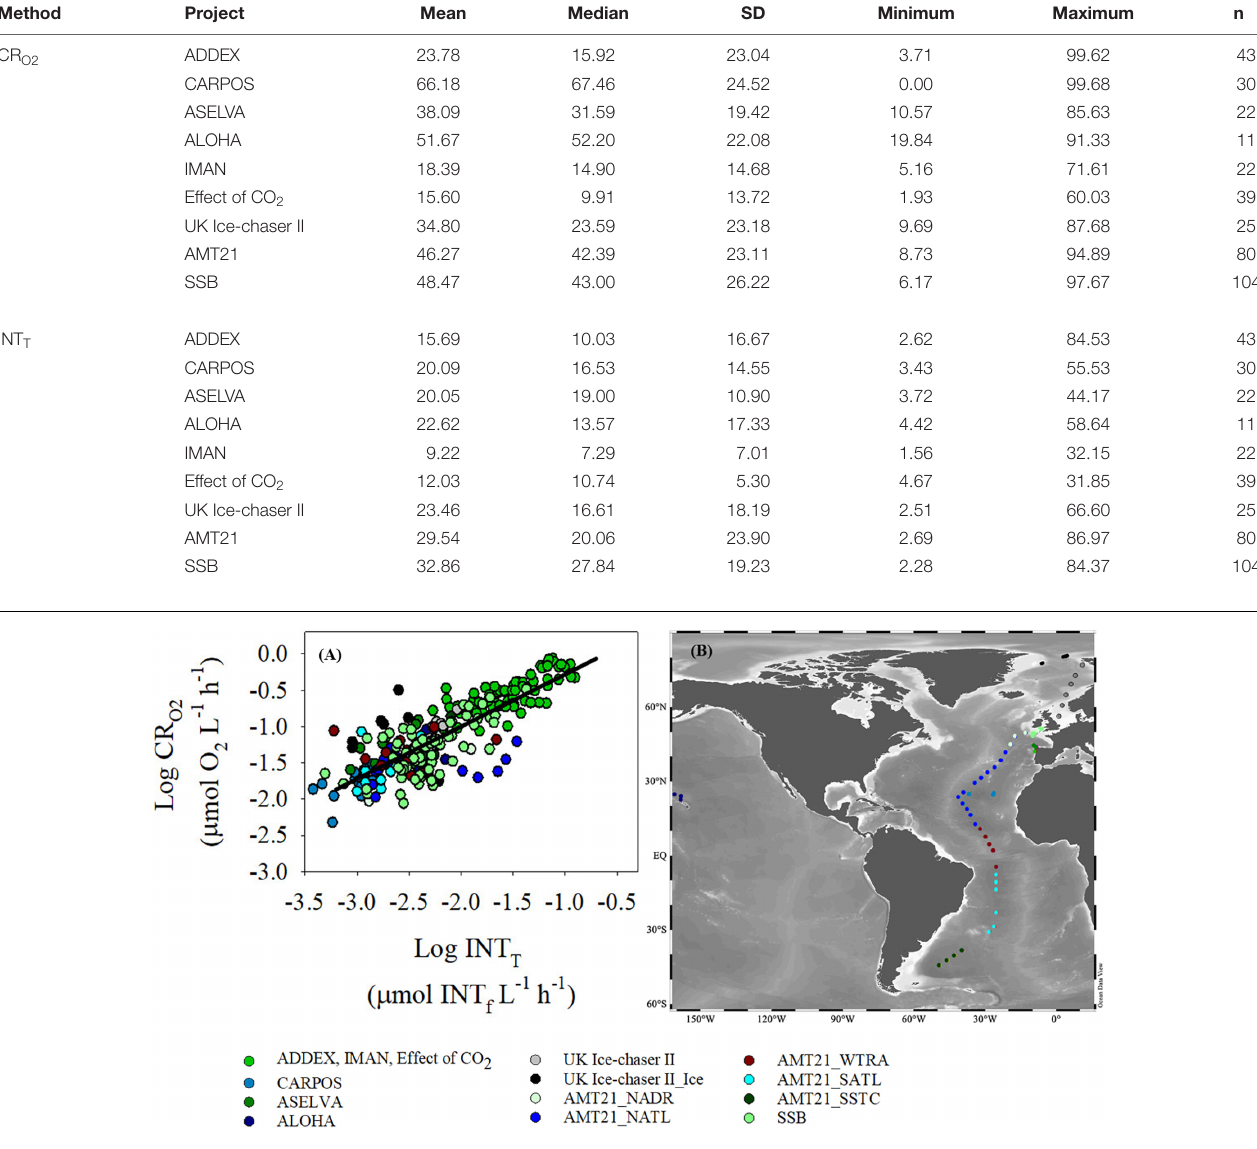
TABLE 2 | Mean, median, standard deviation (SD), minimum and maximum values and number of data (n) for the average of the coefficient of variation for each data of the dissolved oxygen consumption (CR O2 ) and INT reduction (INT T ) methods within each project. Method